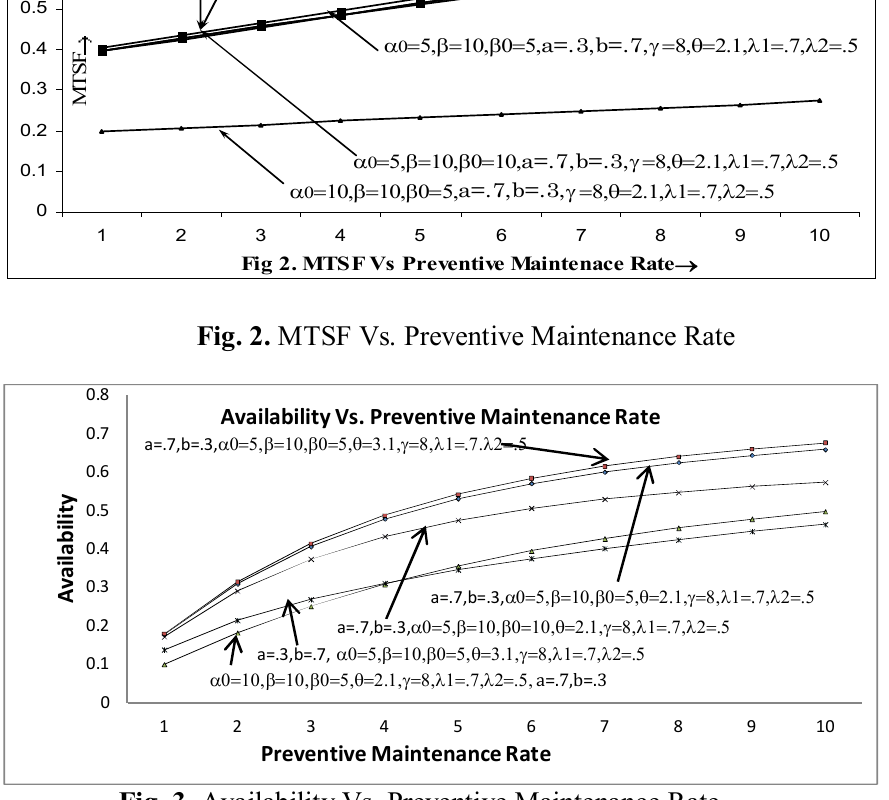
Fig. 3. Availability Vs. Preventive Maintenance Rate